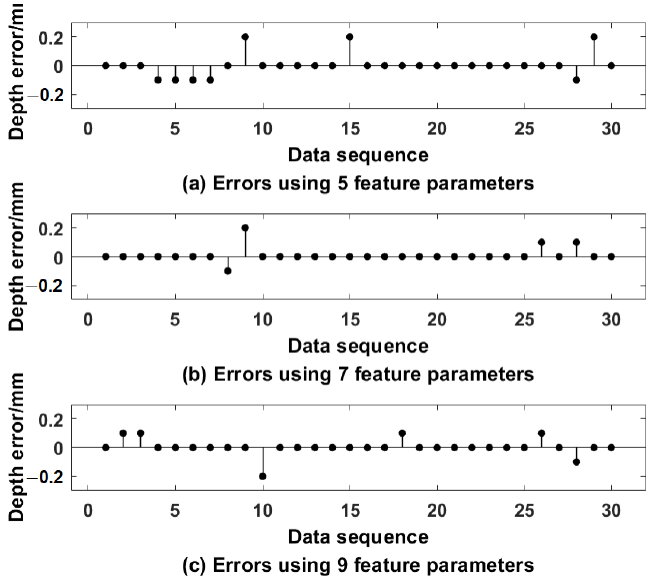
Figure 18. SVM depth prediction errors.